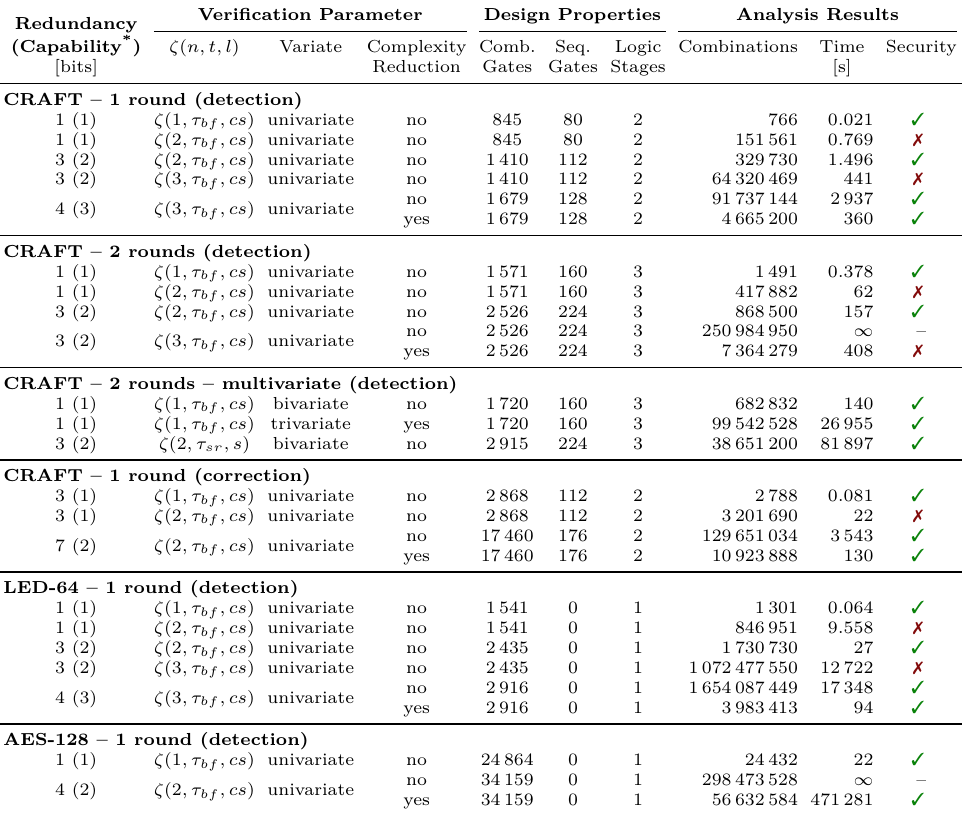
Table 1: Evaluation results for various ciphers protected against different levels of fault injections. A red cross in the last column indicates that the tool found effective faults which, however, is expected since the capabilities of the countermeasures were exceeded for these experiments. Experiments with simulation times marked by ∞ were not finished in a reasonable time such that we only report the number of